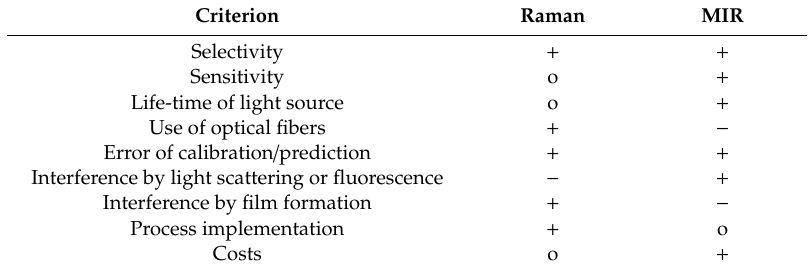
Table 3. Comparison of the functionalities of Raman versus MIR-ATR spectroscopy for bioprocess monitoring ( + advantage, o su ffi cient, − disadvantage /